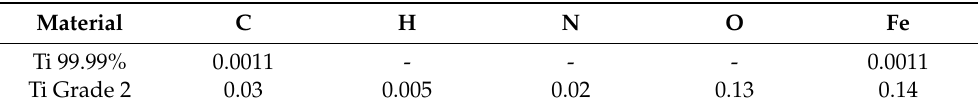
Table 1. The content of impurities (including interstitial elements: C, H, N, O) in Ti 99.99% and Ti Grade 2 (in wt. %)